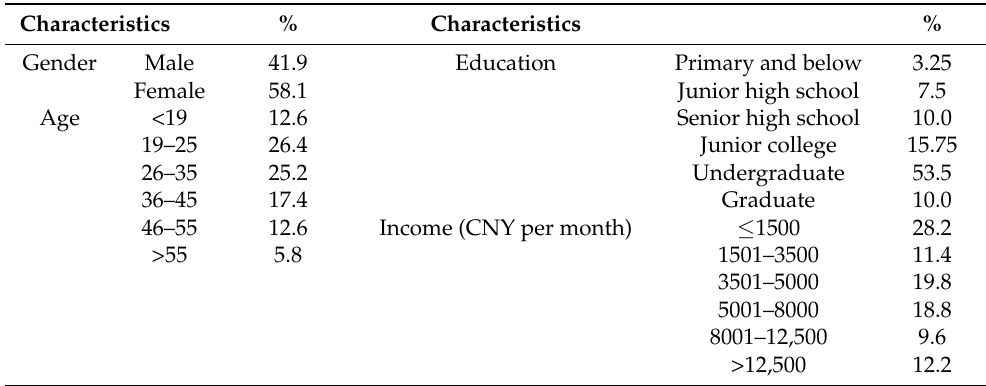
Table 4. Sample characteristics.